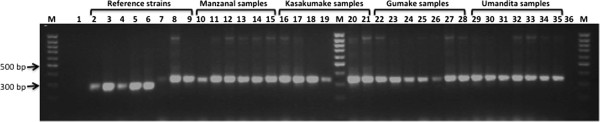
Genetic characterization of the parasites by the amplification of the intergenic regions of the mini-exon genes. Agarose gel electrophoretic analysis of the amplification products from the reference strains belonging to TcII (2–3), TcIV (4–5), TcVI (6), TcI (7–9) and different samples isolated from the Manzanal (10–15), Kasakumake (16–21), Gumake (22–28) and Umandita (29–35) communities of SNSM, Colombia. Samples 1 and 36 are negative controls, and M is the 100-bp ladder molecular weight marker.